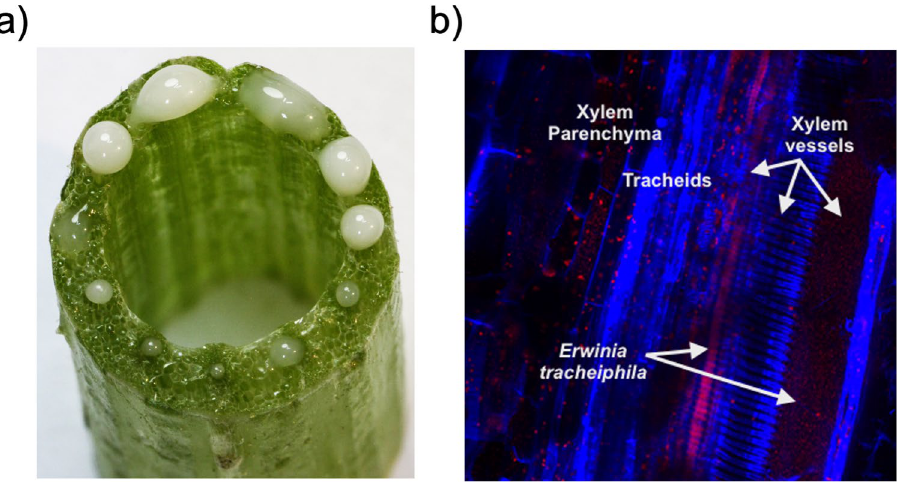
Figure 1. Xylem colonization by E. tracheiphila . ( a ) Visible strain of E. tracheiphila (Wt) oozing from xylem in all vascular bundles of a symptomatic plant after a horizontal stem cross section cut. ( b ) ×20 confocal microscopy image of a longitudinal section of a symptomatic, E. tracheiphila infected Cucurbita pepo stem. Image is falsely colored so that plant structures are shown in blue and live E. tracheiphila bacterial cells are